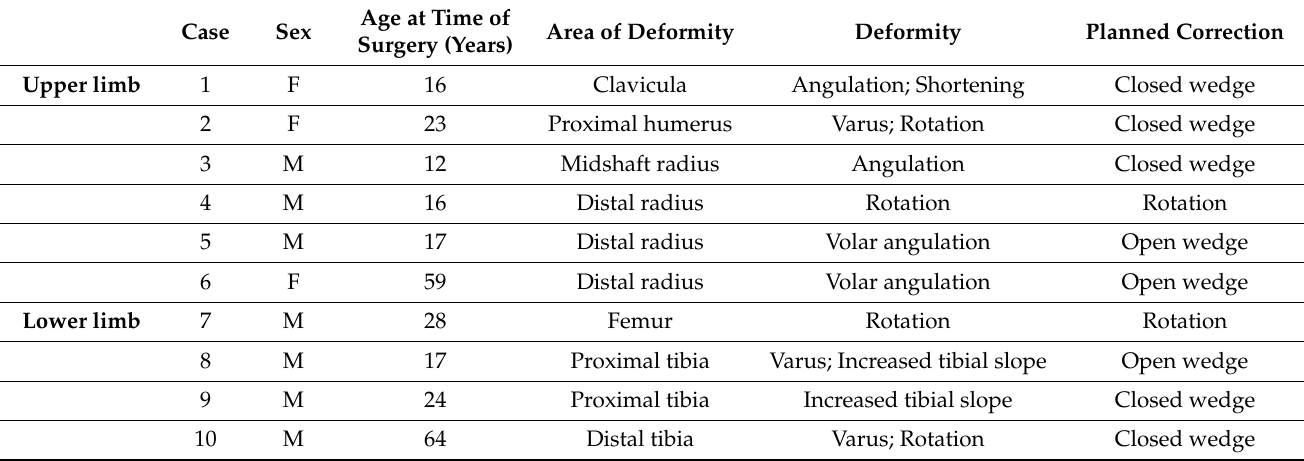
Table 1. Patient characteristics.